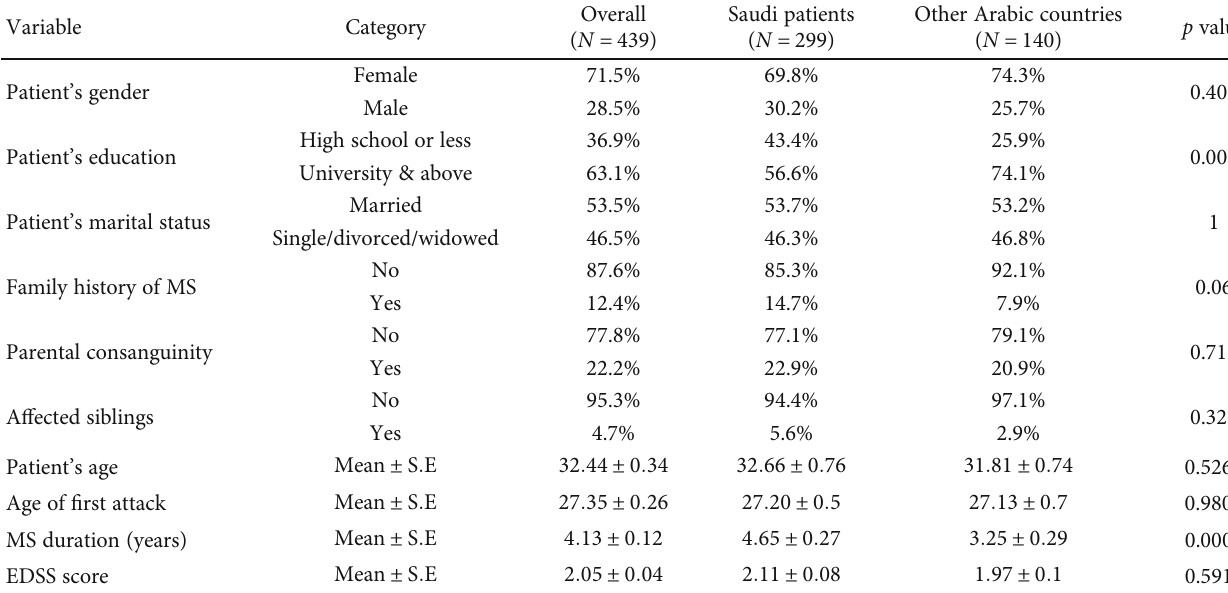
Table 1: Key patients ’ baseline demographics and clinical